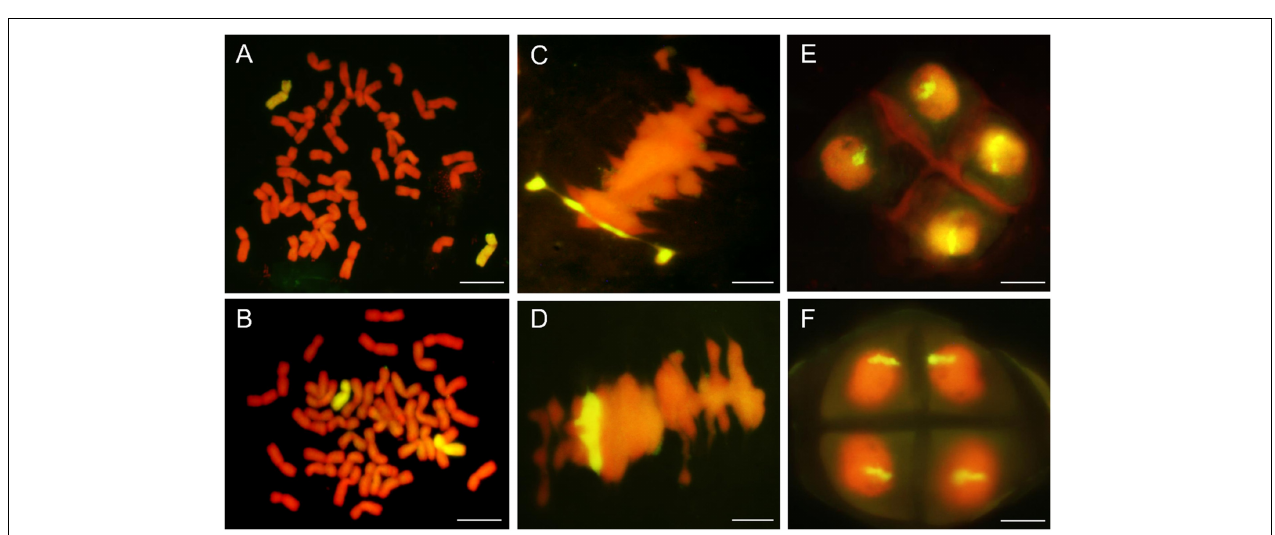
FIGURE 2 | Genomic in situ hybridization (GISH) analysis of line DH109 and line DM131. GISH analysis of RTCs in the mitotic metaphase. (A) In DH109, two chromosomes with yellow–green signals were detected as alien chromosomes from P. huashanica . (B) In DM131, two chromosomes with yellow–green signals were detected as alien chromosomes from L. mollis . GISH analysis of PMCs in the mitotic metaphase. (C) Alien chromosomes formed a rod bivalent with fluorescent signal in DH109. (D) Alien chromosomes formed a ring bivalent with fluorescent signal in DM131. GISH analysis of gametes in the meiosis telophase II. (E) Each of the four progeny cells had a fluorescent signal in DH109. (F) Each of the four progeny cells had a fluorescent signal in DM131. Chromosomes were counterstained with propidium iodide (red). Scale bar, 10 µ m.